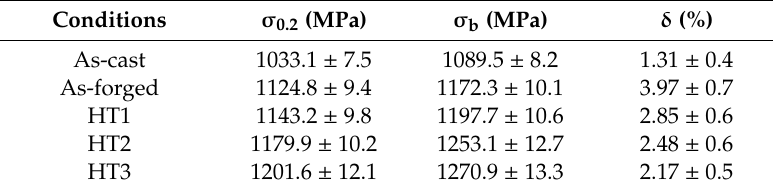
Table 2. Room temperature tensile properties of the composites before and after thermomechanical